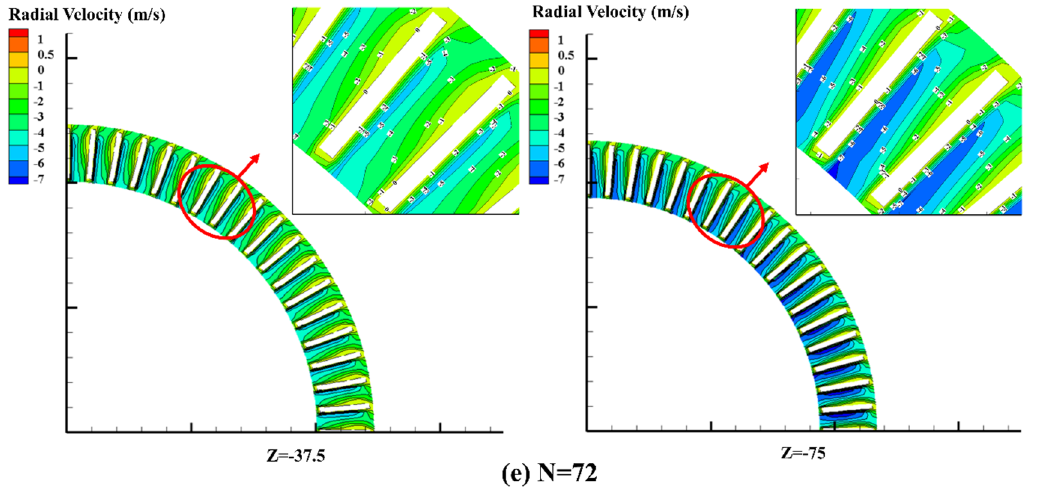
Figure 8. The cloud diagram for the radial velocity distribution corresponding to the different numbers of blades.